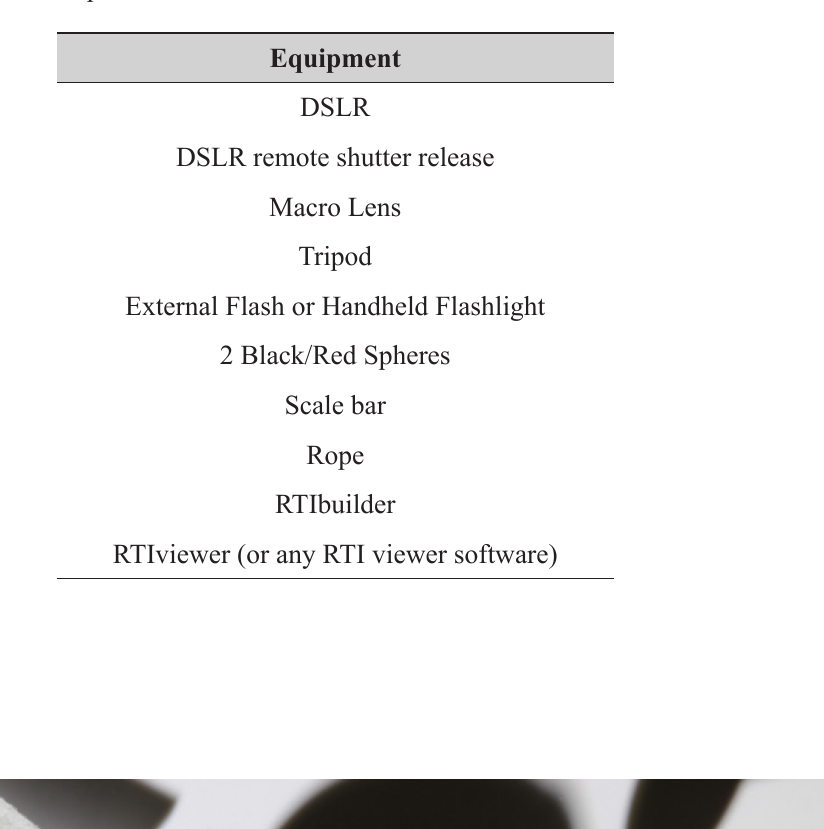
Table 2.3. Equipment list to perform